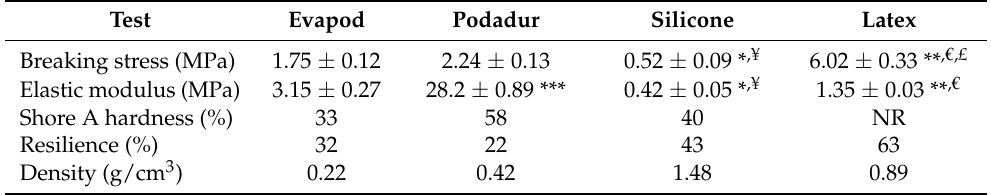
Table 1. Mechanical and physical tests (mean ± standard